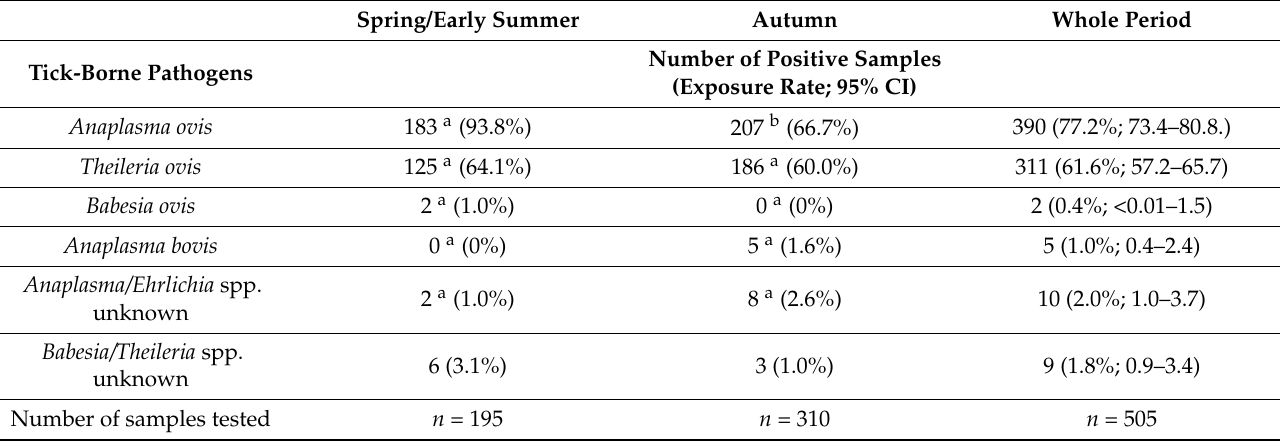
Table 2. Presence of single pathogens and their respective rates in sheep (multiple presence not considered), stratified based on species and collection period. Different superscripts (a and b) indicate significant differences at the p < 0.001 level (abbreviations: CI, confidence